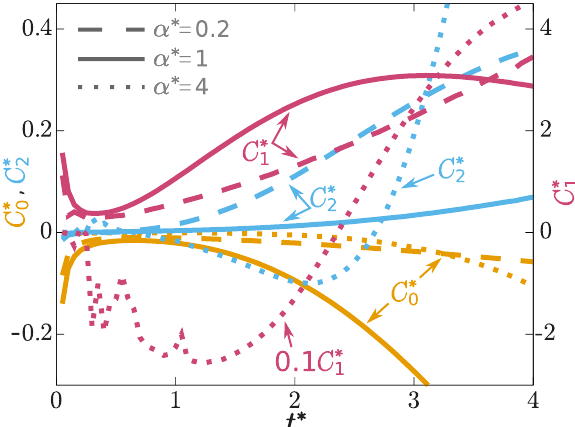
(cid:112) (cid:112) = C = C m ω /¯ h 3 (yellow), C ∗ m ω /¯ h 3 (violet) Figure 3. Scaled amplitudes C ∗ 0 1 0 1 (cid:112) = C m ω 3 /¯ h 3 (blue) of the functional approximations for τ exc , F v and F a , cf. and C ∗ 2 2 Equations (8), (10) and (11), as a function of the scaled time t ∗ = t ω for three different values of the interaction length, as indicated. Note the different scales (left and right vertical axes). The data set C ∗ ( α ∗ = 4) has been scaled with a factor 0.1, as indicated, for a better 1